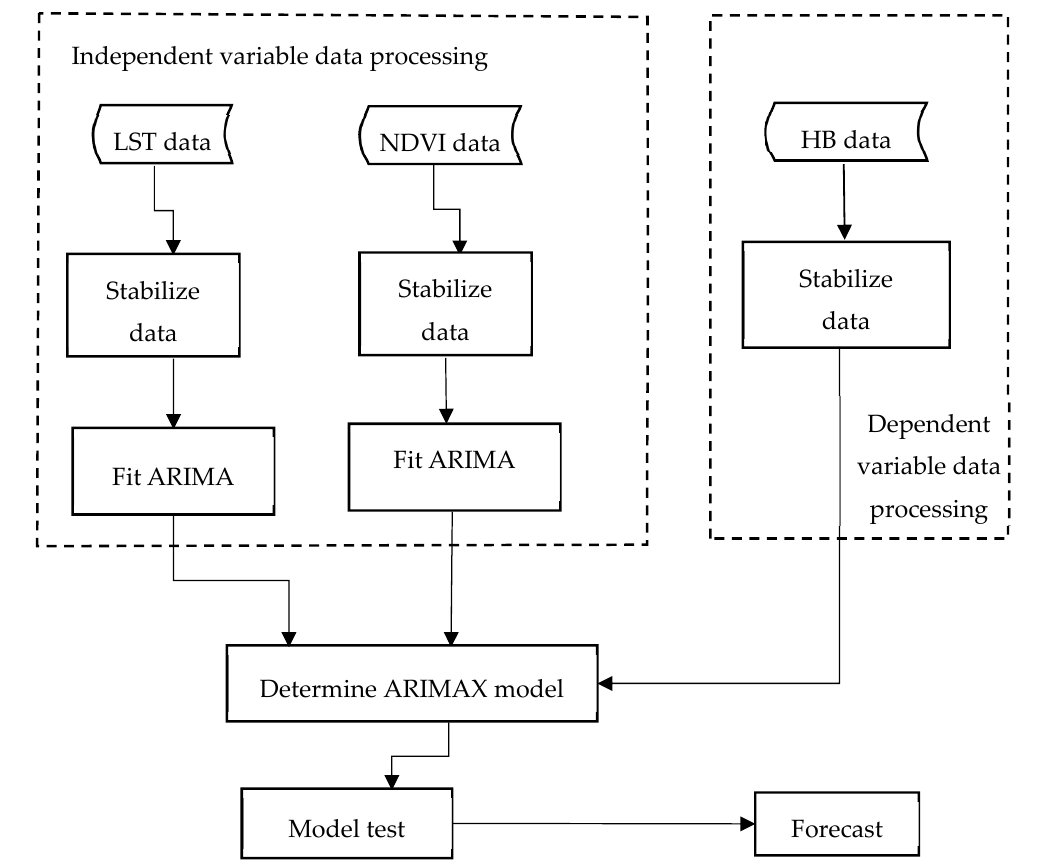
Figure 1. Data processing and modelling flowchart. LST represents land surface temperature, NDVI expresses normalized difference vegetation index, HB indicates human brucellosis.